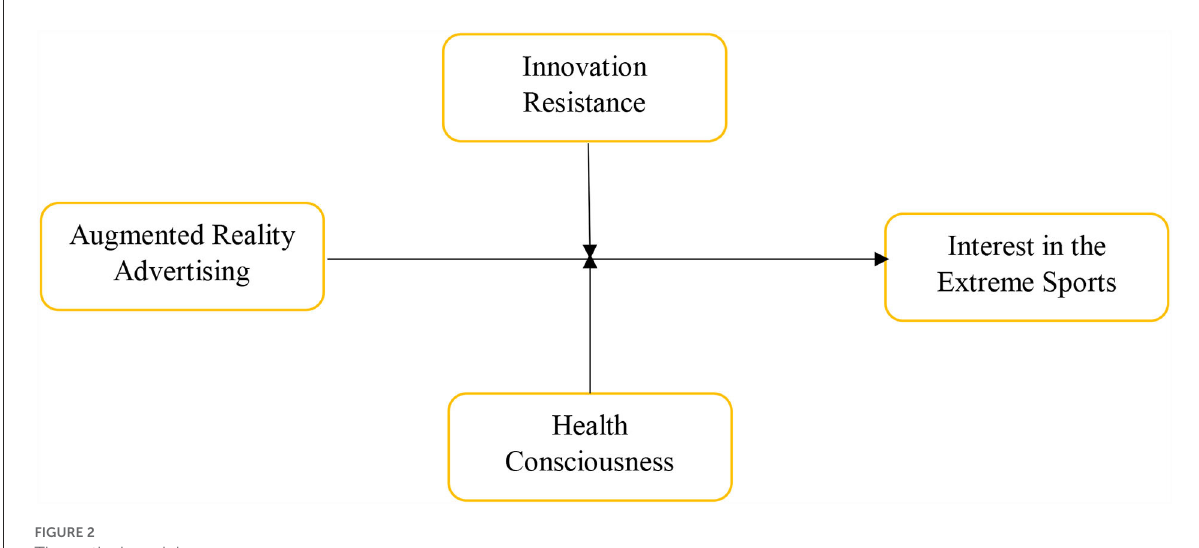
FIGURE2 Theoretical model.